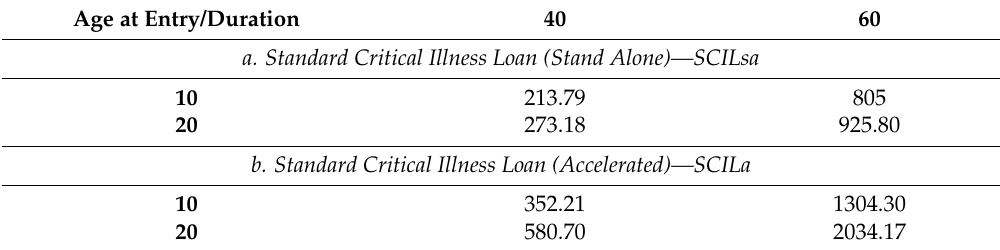
Table 3. Actuarial periodic premium—female smokers. Issue time 2014, r = 2%, i = 7%, C = 200,000.